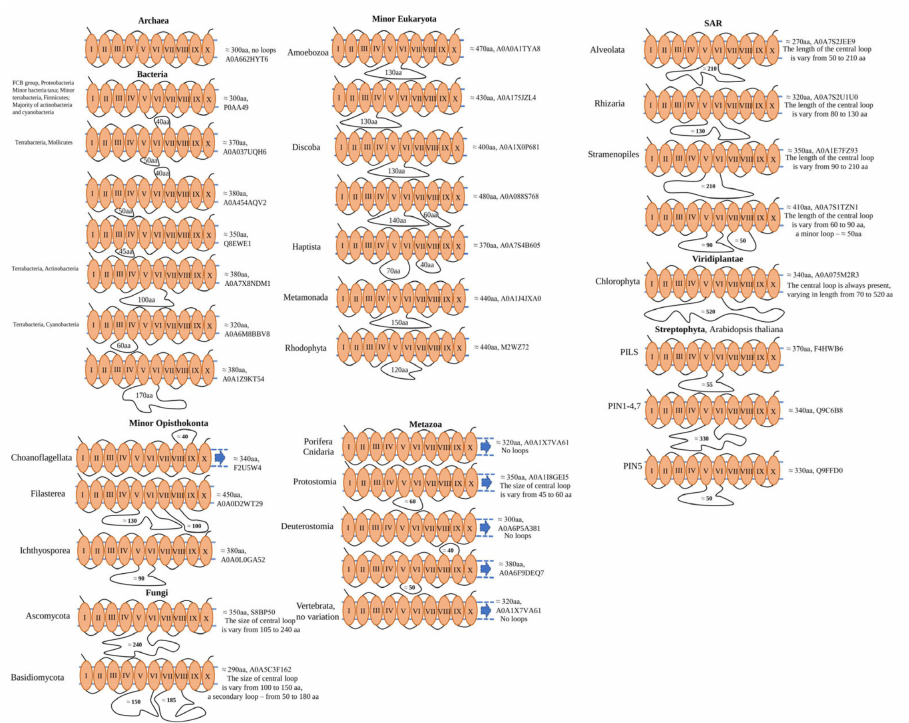
Figure 1. Domain organisation of MTP domain-containing proteins in the different taxa. Designated loop length is applied only to a particular protein (referred to as UniProt ID). Taxa-specific description of loop length is referred to as “no loops” or varies. The presence of other domains is designated with a blue arrow. Upward loops represent non-cytoplasmic, and downward—cytoplasmic